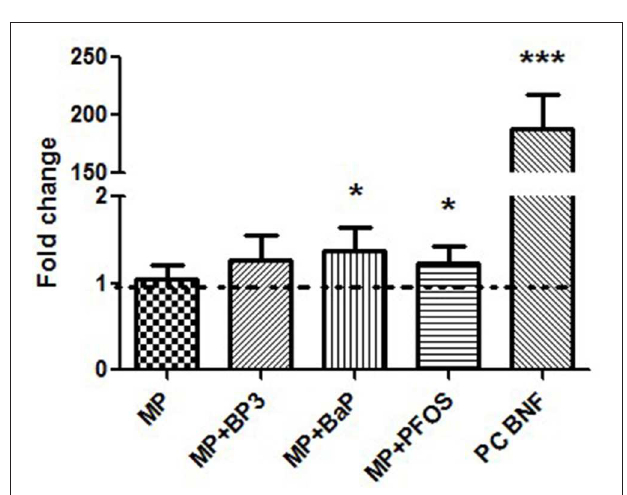
FIGURE 4 | Induction of cyp1a gene transcription in 96 hpf zebrafish ( Danio rerio ) embryos after exposure to 10 mg/L of microplastics (MP), microplastics spiked with benzophenone 3 (MP + BP3), microplastics spiked with benzo[a]pyrene (MP + BaP), microplastics spiked with perfuorooctane sulfonate (MP + PFOS) as well as a positive control (75 µ g/L β -naphthoflavone). Transcription of cyp1a is given as fold-change relative to the negative control (dashed line) after 3h exposure to MP + pollutant starting at 96 hpf. Data are given as means ± SD ( n = 4; ANOVA on ranks: * p < 0.05, *** p <